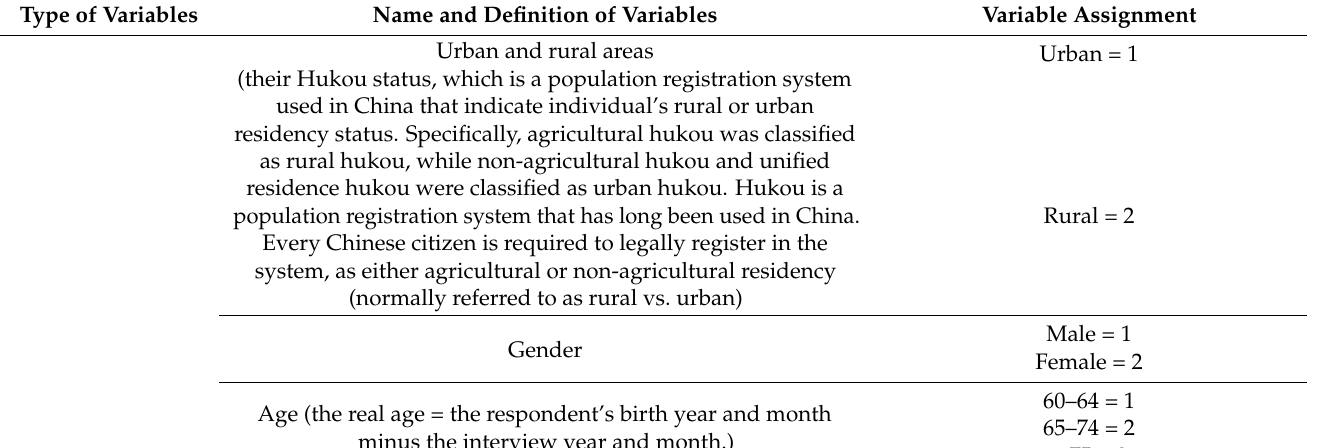
Table 1. Description of variables used in this